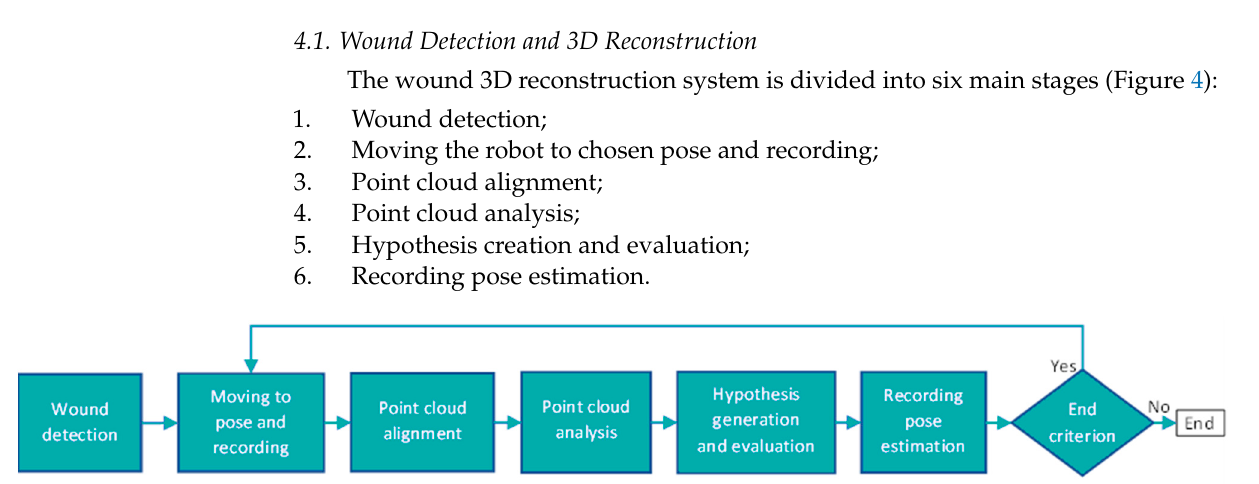
Figure 3. Medical models used in this research: ( a ) Seymour II wound care model; ( b ) Vinnie venous insu ffi ciency leg model.